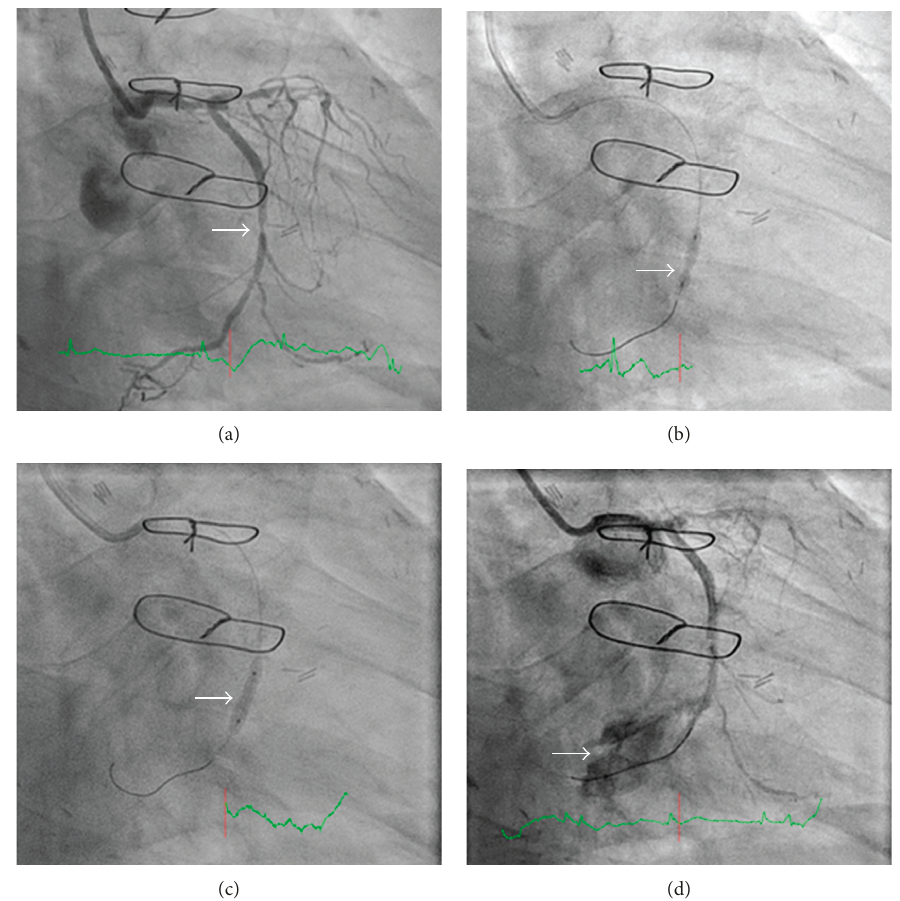
Figure 1: (a) Severe stenosis of the mid circumflex artery before intervention. The circumflex provides collaterals to the RCA. (b) Persistent “waisting” (stenosis) after dilating with a 2.5mm compliant balloon. (c) Loss of waist after inflation of a 2.5mm AngioSculpt balloon. (d) Ellis III perforation after dilation with a 2.5 mm scoring balloon.